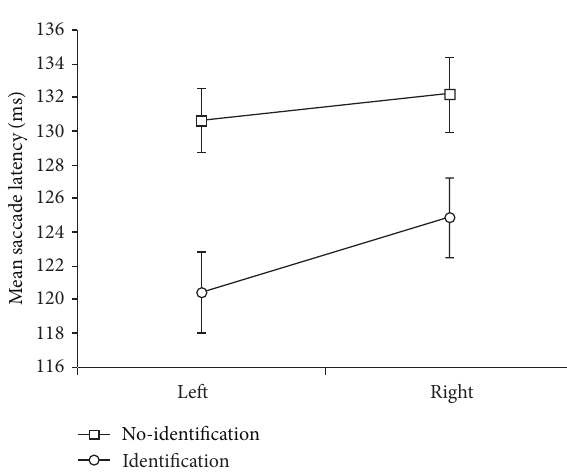
Figure 5: Mean saccadic latencies for the two-way interaction of identification × direction from fixation. Error bars = ± 1 SEM.